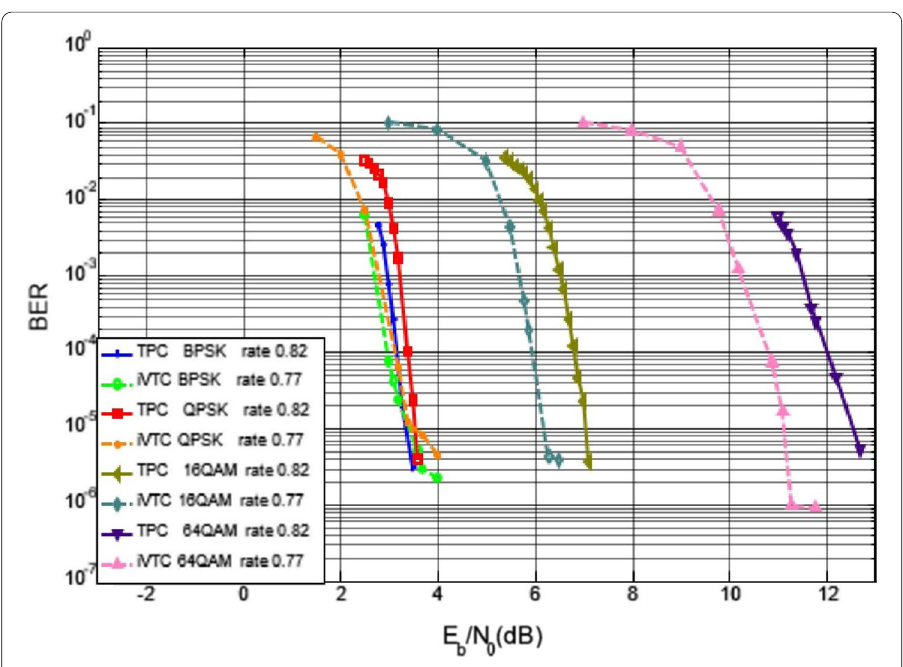
Fig. 4 (63, 57)TPC and equivalent iVTC BER versus E b / N 0 for BPSK, QPSK, 16QAM and 64QAM